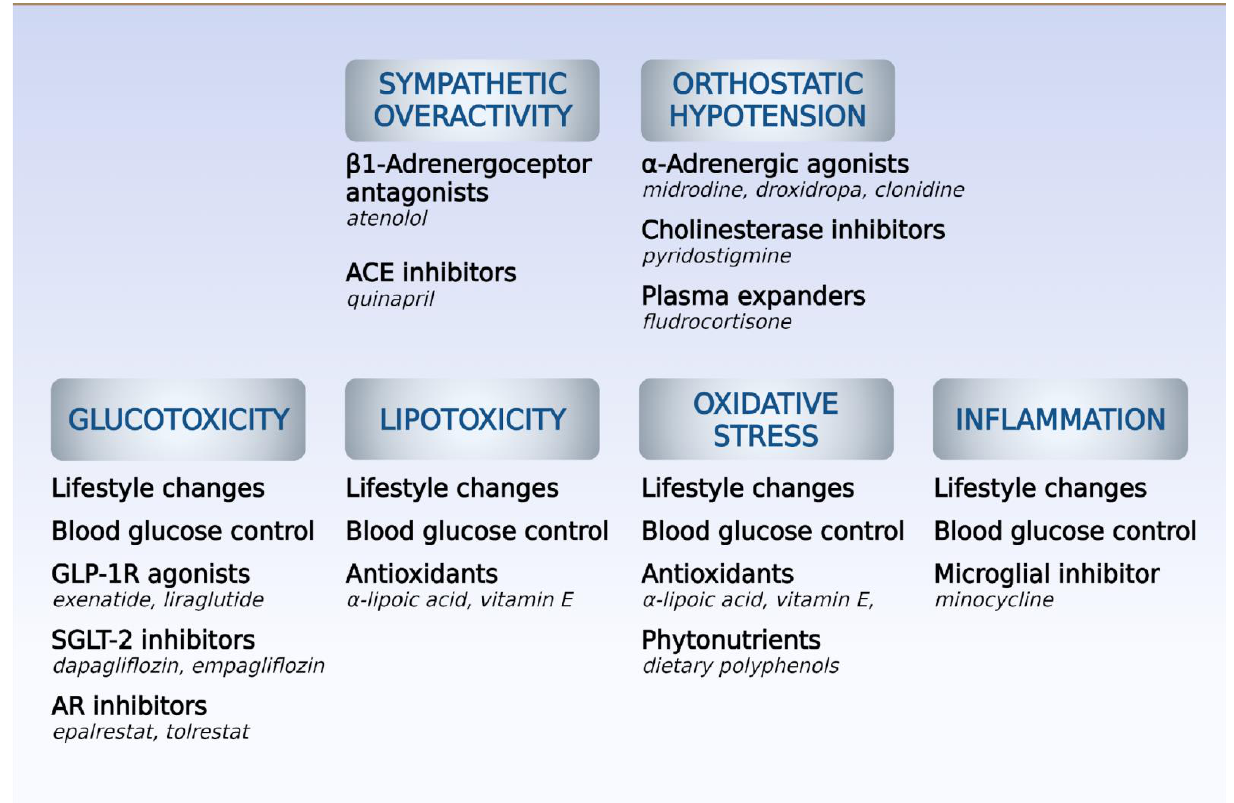
Figure 3. Pharmacological strategies for management of main causes and symptoms of diabetic cardiac autonomic neuropathy (DCAN). ACE, angiotensin-converting enzyme; GLP-1R, receptor for glucagon-like peptide-1; SGLT-2, sodium/glucose cotransporter 2; AR, aldose reductase. Source: Own authorship.